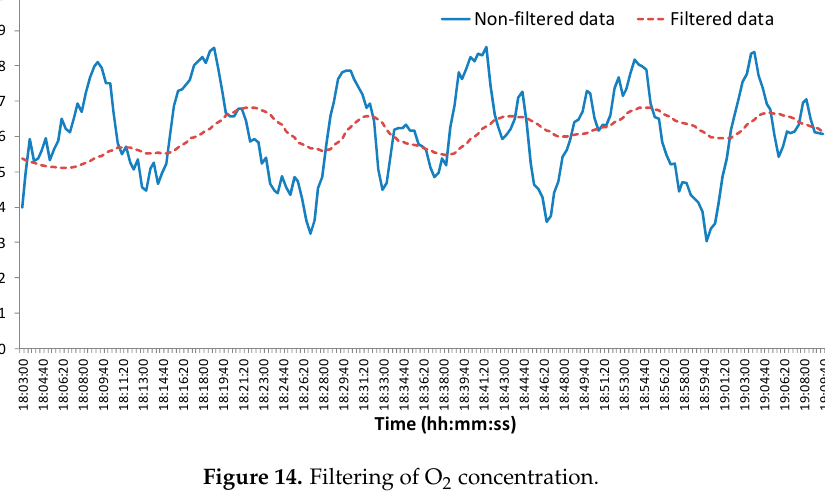
Figure 14. Filtering of O 2 concentration.